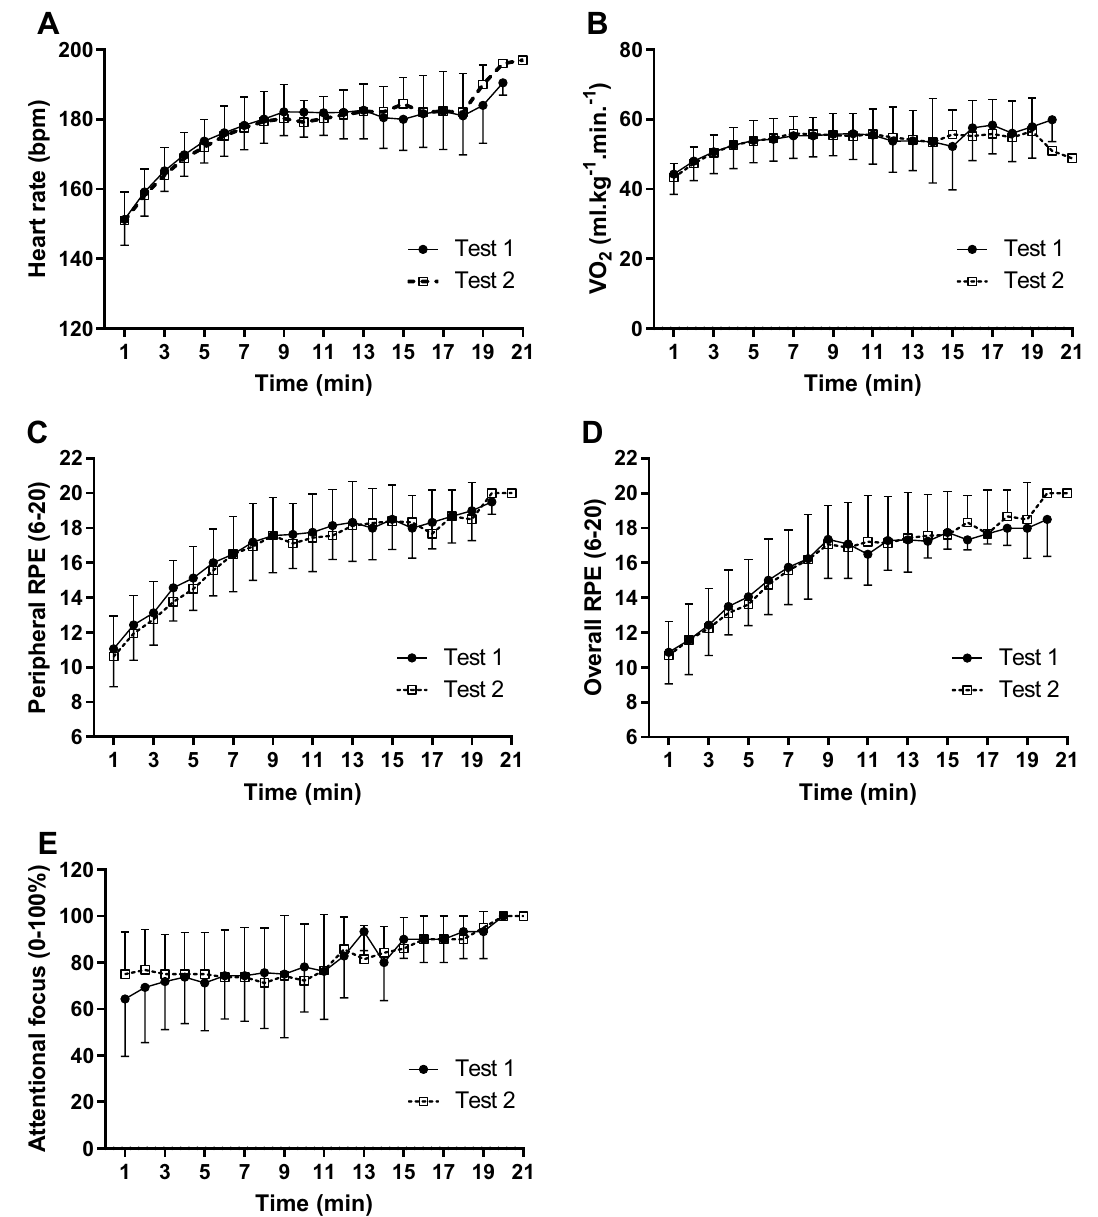
Figure 4. Physiological and psychophysiological responses during the two best performances in time to exhaustion test with 80% of peak power in athletes (n = 16). Heart rate ( A ), oxygen uptake ( B ), perceived exertion of the lower limbs ( C ), perceived exertion of the whole-body ( D ), associative thoughts ( E ), and affective responses ( F